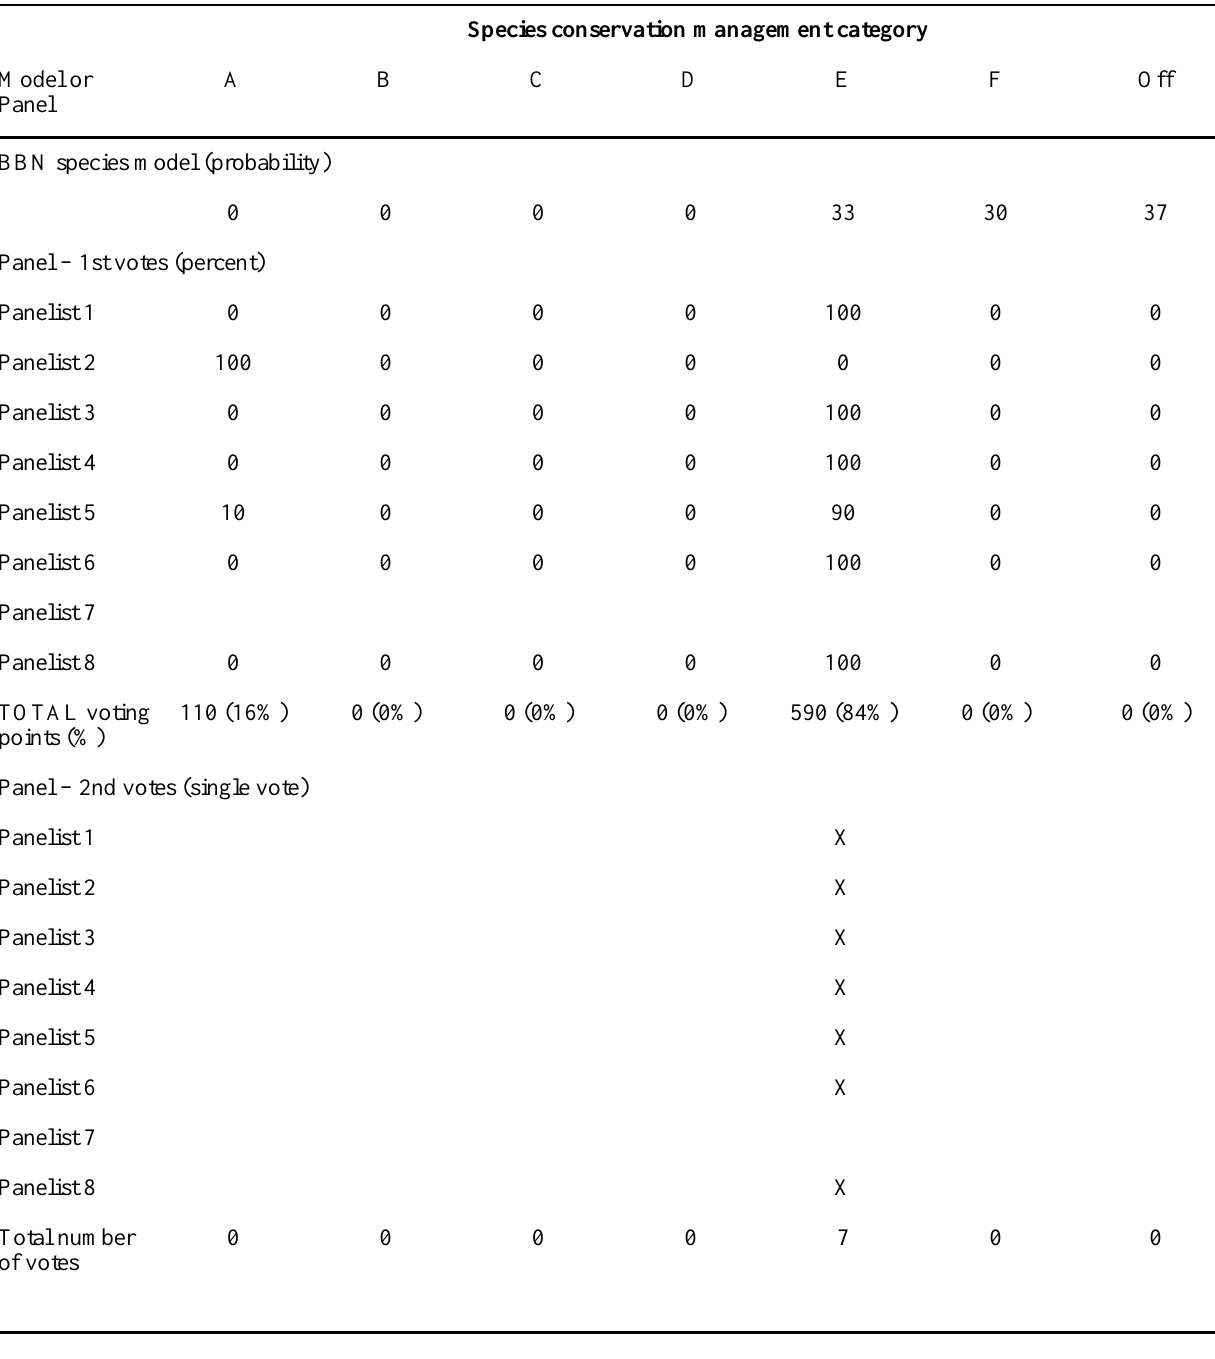
Table 4. An example of an evaluation of a species of rare lichen, Fuscopanaria saubinetii, from the 2003 annual species review, showing outcomes of the Bayesian belief network (BBN) decision models and the voting results from the evaluation panel. Panelist 7 was absent during this particular panel. The prior (2002) conservation management category for this species was category F (see Table